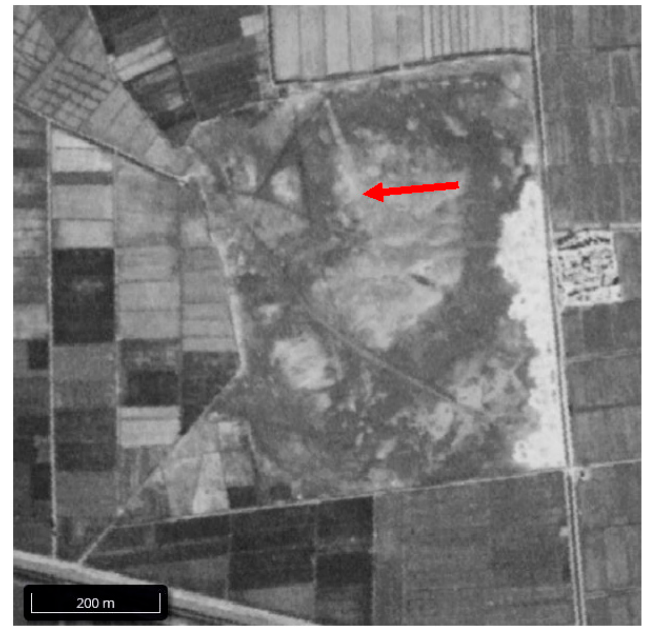
Figure 2. CORONA KH-4B satellite image of Tell Tebilla, taken in 1972. Note the red arrow pointing to the enclosure wall of the Late Period (ca. 712–332 BC) temple. Imagery courtesy of the Center for Advanced Spatial Technologies, University of Arkansas/U.S. Geological Survey.